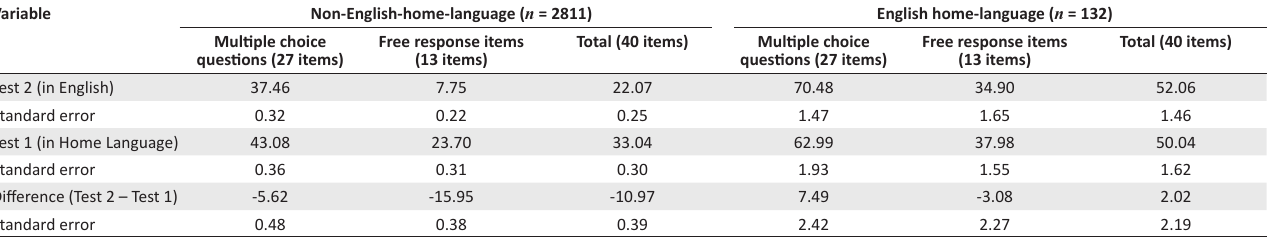
TABLE 9: Average literacy score ( % ) by question format between Test 1 (Systemic Evaluation) and Test 2 (National School Effectiveness Study) for students whose home language is not English and those for whom it is (standard errors clustered at the individual level). Variable Non-English-home-language ( n = 2811) English home-language ( n =